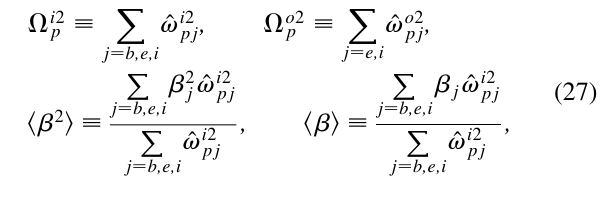
(cid:1) r (cid:2) versus r=r z (cid:7) 0 . p